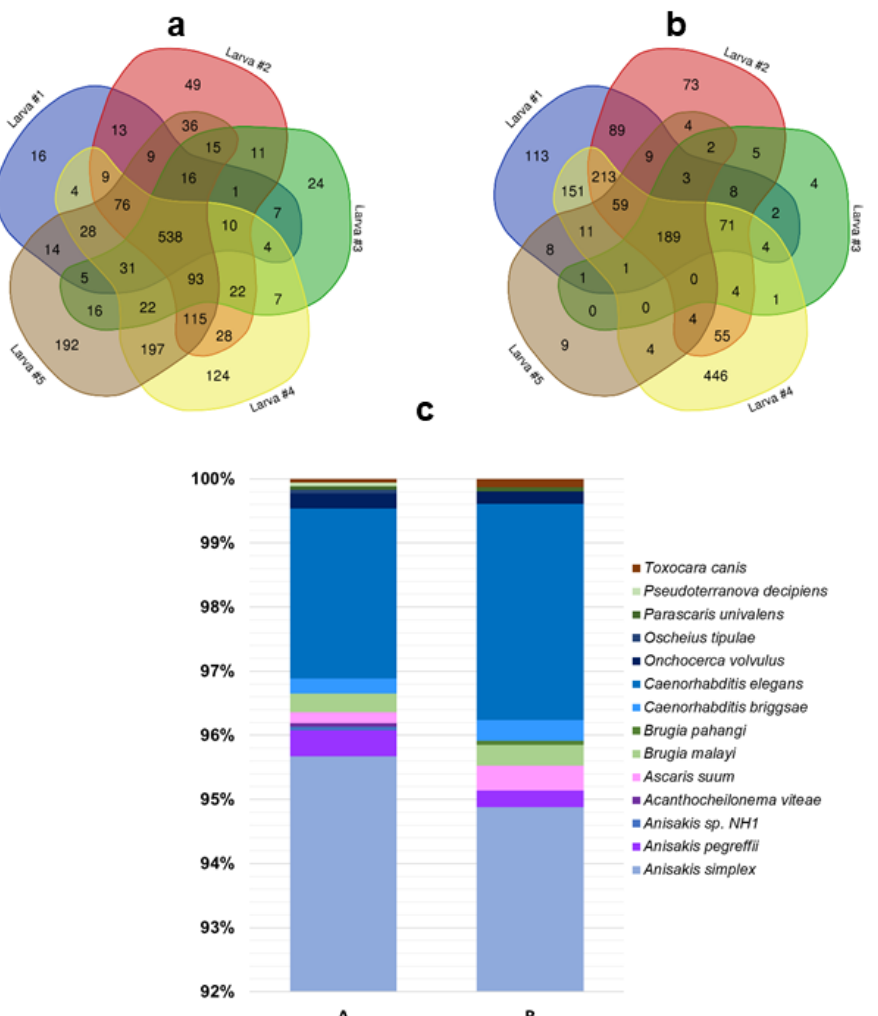
Figure 5. Overview of proteins identified by LC–ESI–MS / MS analysis. Venn diagrams show the number of Rhabditida proteins and their distribution in the five analyzed larvae, highlighting shared and exclusive proteins (numbers in colored areas) in samples A ( a ) and B LC ( b ). The organism distribution (as percentage of identified proteins) at the Rhabditida order taxonomy level in sample A and B is depicted with histograms ( c ).